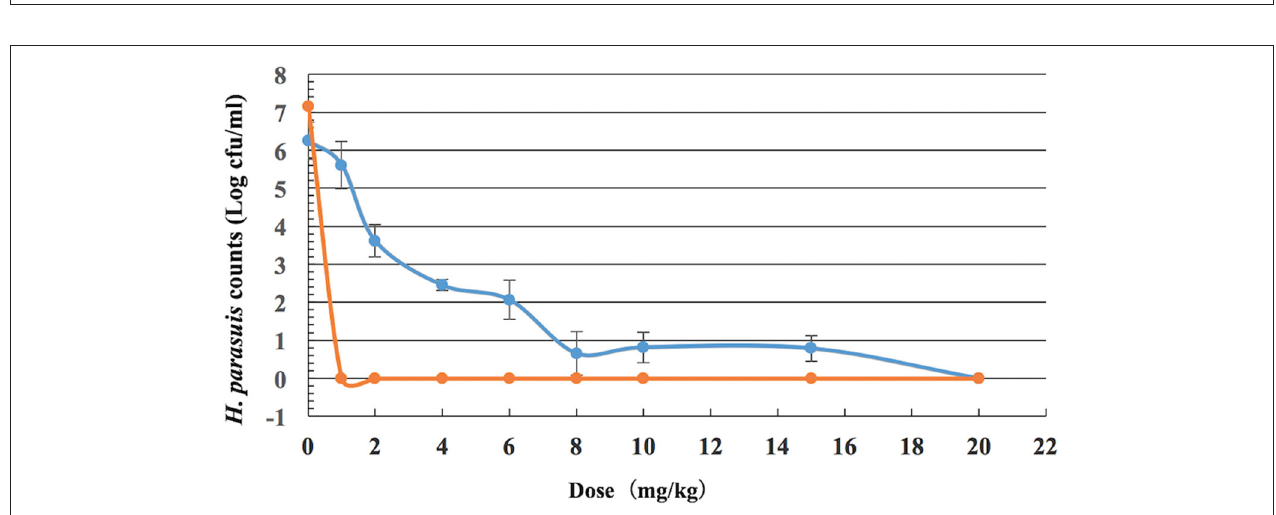
FIGURE 2 | The time-concentration curve of tulathromycin in lung tissue for each of three intramuscular administrations of 1, 10, and 20 mg/kg in a H. parasuis infection model ( n = 8/time point).